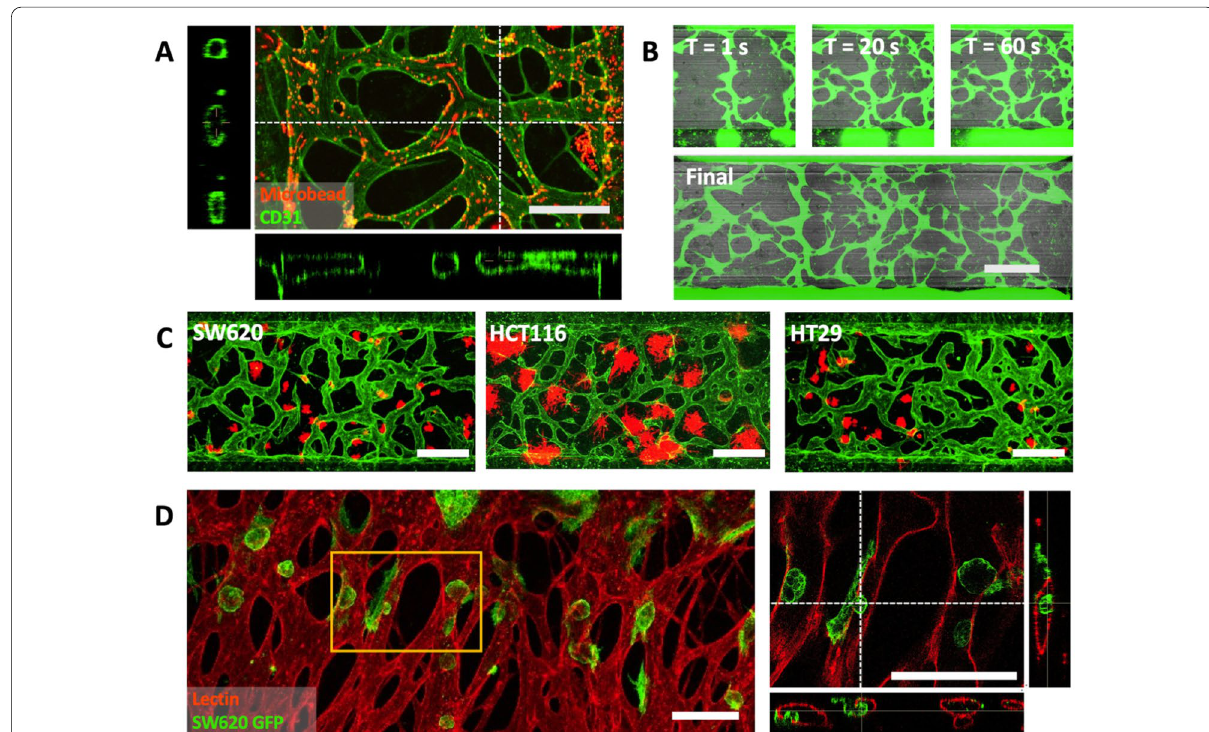
Fig. 5 Overview of engineered end to end perfusable vasculature. A Confocal imaging of micro bead flow assay utilizing 2 µm beads through perfusable vasculature cultured within the chip. B Fluorescent dye assay showing FITC dye flow through the perfusable vasculature. C Confocal images of perfusable vasculature cultured with extravascular micro tumors. D Confocal images of intravascular micro tumors attached to and breaching the lumen. All scale bars are 500